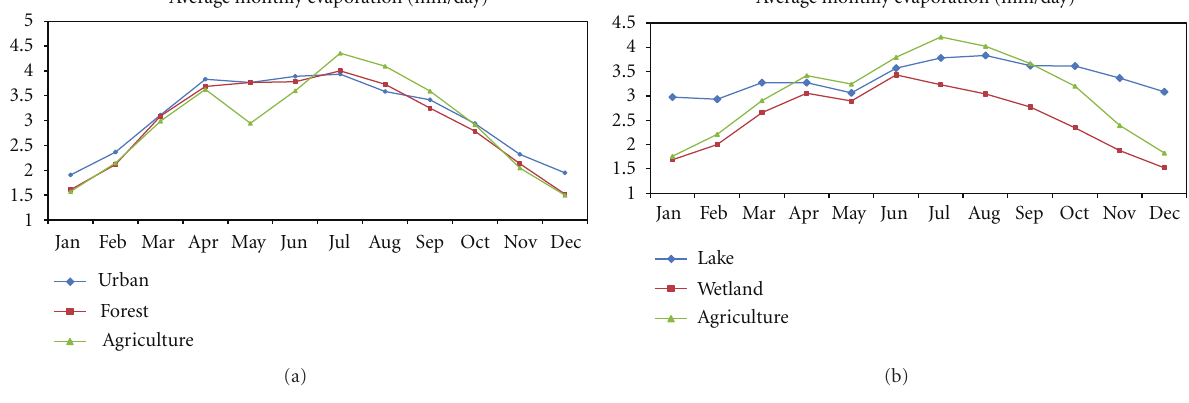
Figure 8: (a) Seasonal variations of the average monthly actual evaporation in Northeast Florida. (b) Seasonal variations of the average monthly actual evaporation in South